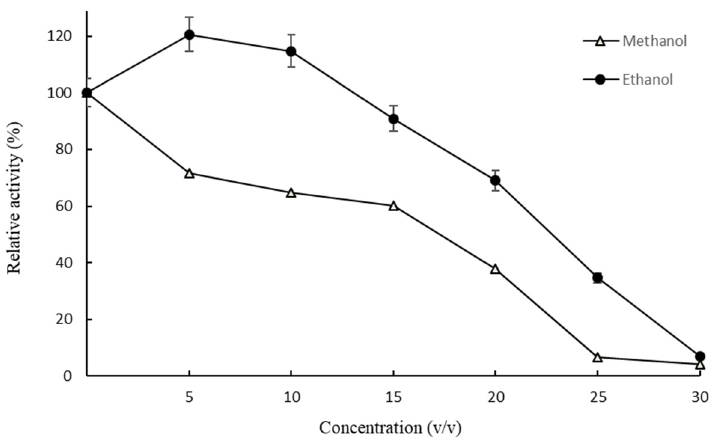
Figure 4. The effects of methanol and ethanol on the enzymatic activity of SpBGL1 with p NPG as substrate. The relative activity of the enzyme is plotted against the concentration of methanol or ethanol in the reaction solution. Each value in the figure represents the mean ± standard deviation ( n = 3).